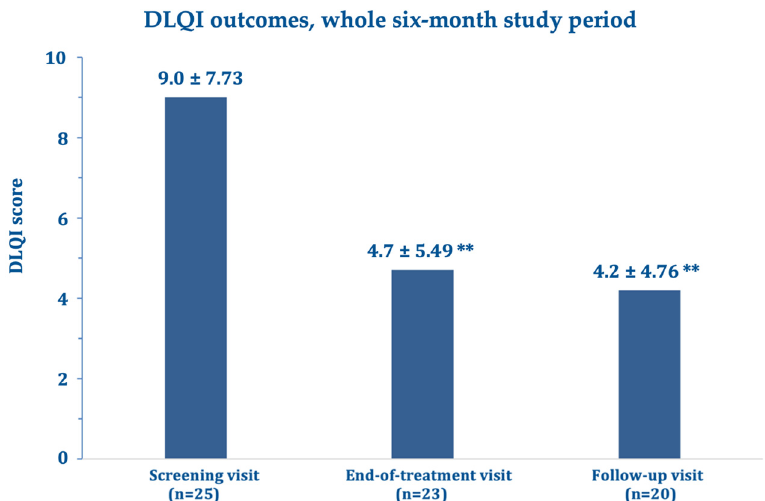
Figure 5. Mean Dermatology Life Quality Index (DLQI) score changes ± standard deviation after 90 (end-of-treatment visit) and 180 days (follow-up visit) vs. baseline (screening visit). ** p = 0.0002 vs. screening visit.